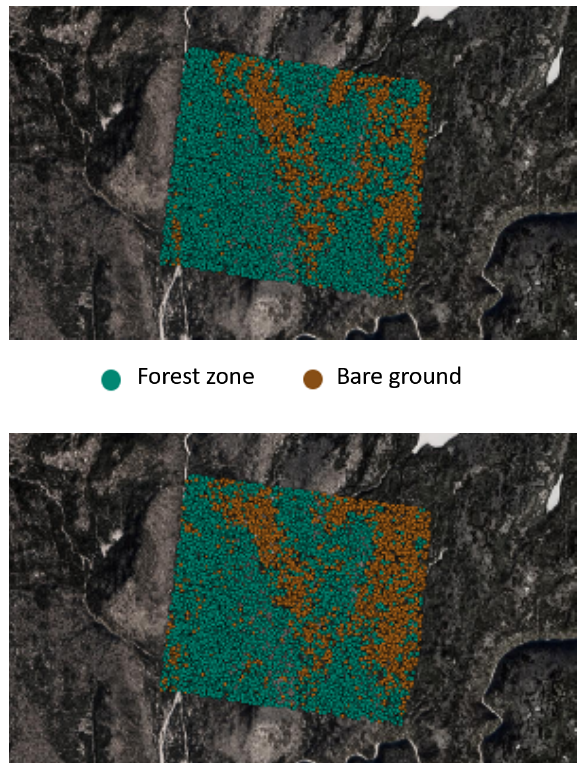
Figure 21. In green/brown: forest/non-forest zone. Top : reference. bottom : Classification done from the first computed Legendre coefficient with a